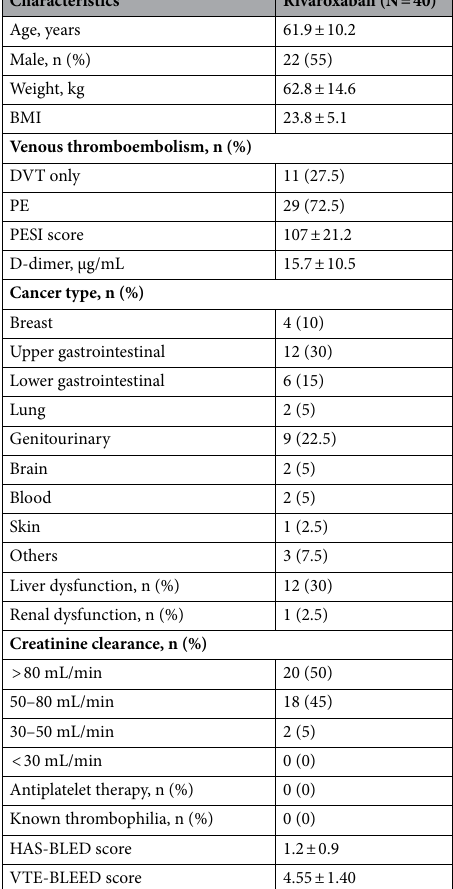
Table 1. Clinical characteristics of patients with VTE. Data are presented as number (%) or mean ± standard deviation. BMI Body mass index; DVT Deep vein thrombosis; PESI Pulmonary embolism severity index PE Pulmonary thromboembolism; VTE Venous